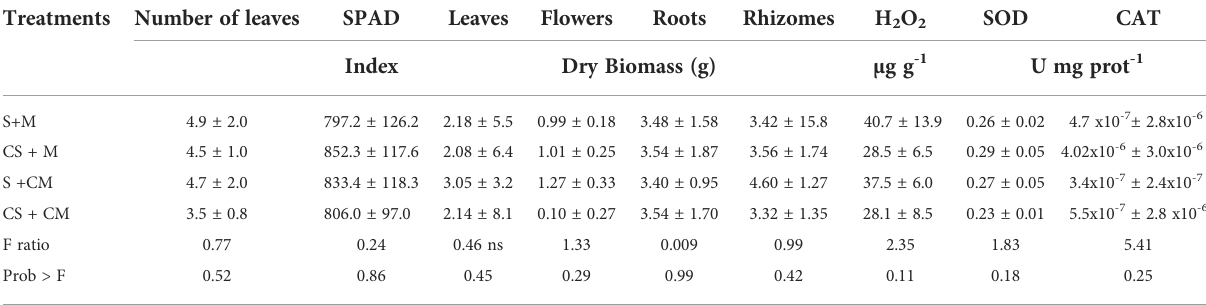
TABLE 1 Number of leaves, SPAD index, dry biomass of distinct organs, H 2 O 2 concentration and activities of Superoxide Dismutase (SOD) and Catalase (CAT) enzymes in calla lily plants grown in substrates with or without enro fl oxacin addition. Treatments Number of leaves SPAD